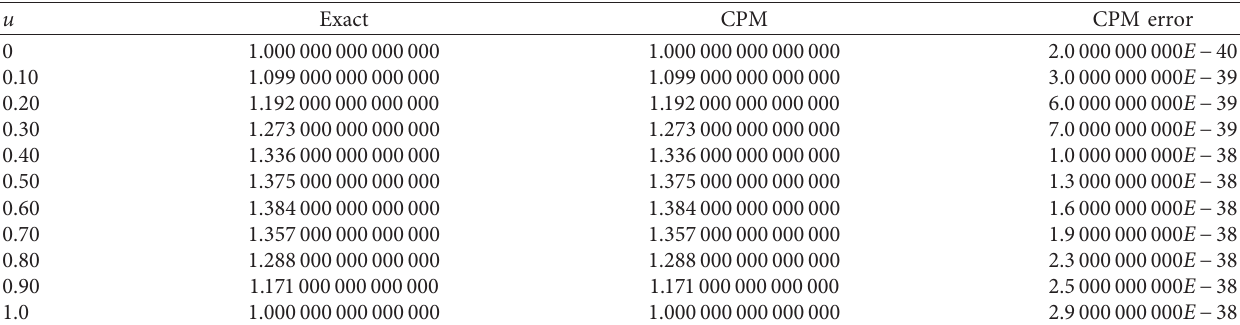
Figure 8: Error graph of MLWM and CPM for problem 3. Table 7: Exact, CPM solution, and CPM A.E at m � 4 of problem 4.